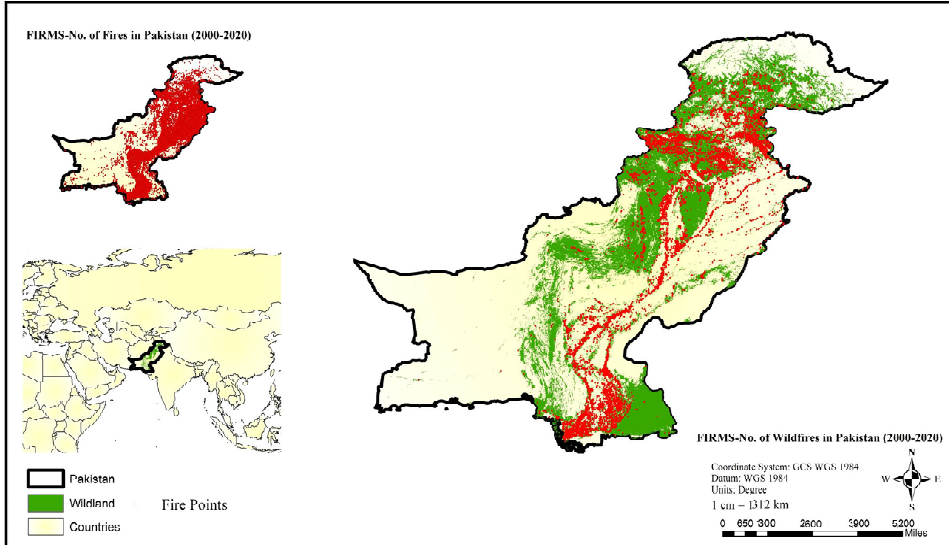
Figure 1. Study area map of wildfires in Pakistan.